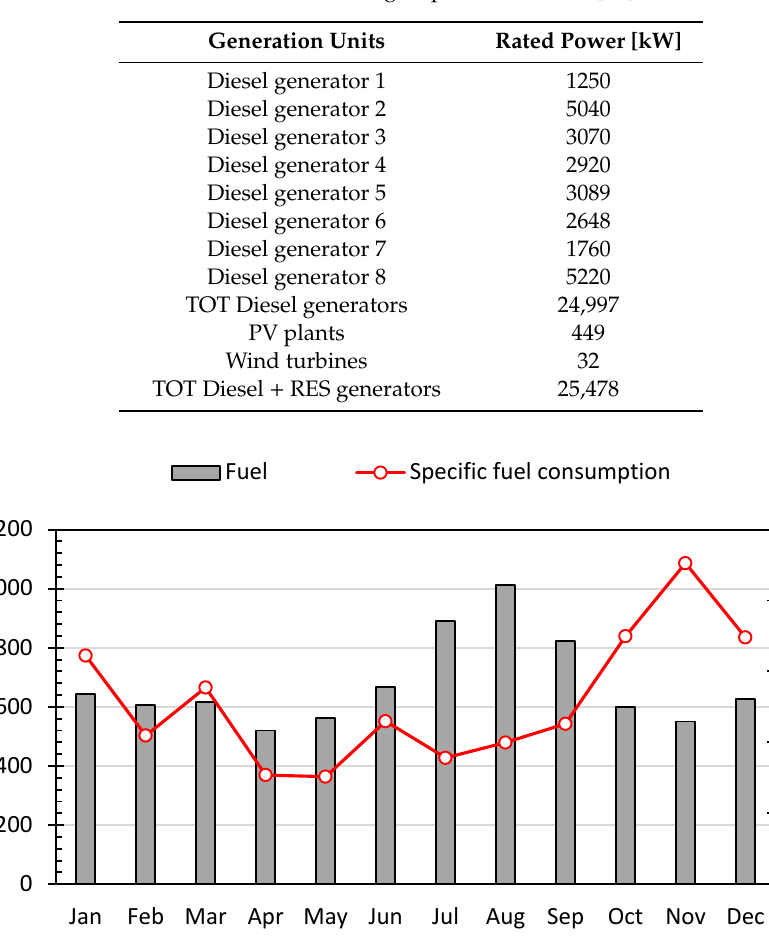
Table 1. Generation groups in Pantelleria [80].